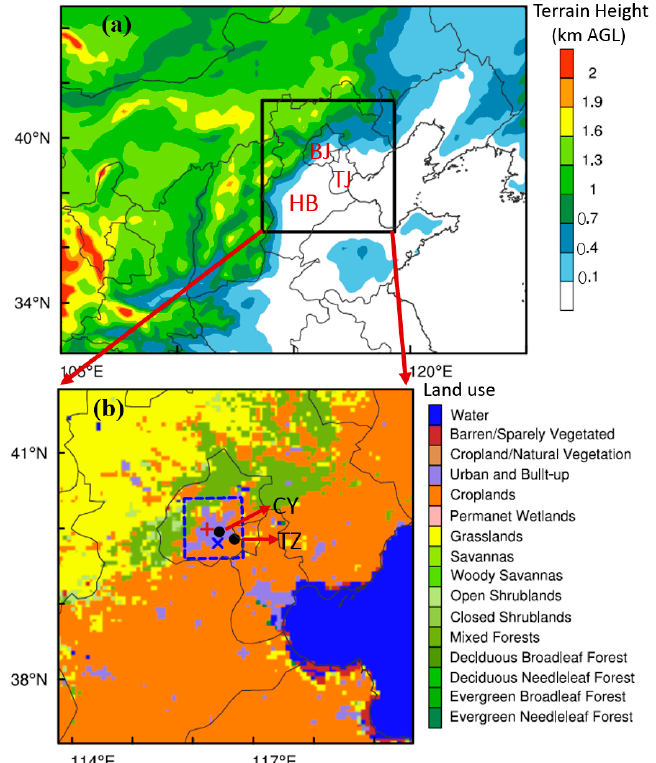
Figure 1. ( a ) Map of terrain height in simulation domains, and ( b ) land use categories in the inner domain. The black square in ( a ) denotes the locations of inner domain, and the blue dashed square in ( b ) indicates the region of interest (ROI) using the zero-out emission configuration. The red plus sign, blue cross, and black dots in ( b ) indicate the locations of wind-profiler, radiosonde site, and surface meteorological stations, respectively. The locations of Beijing, Tianjin, and Hebei are indicated by the red texts “BJ”, “TJ”, and “HB” in ( a ). The PM 2.5 concentrations are also measured at those surface meteorological stations in Beijing, including Chaoyang (CY) and Tongzhou (TZ). AGL: above ground